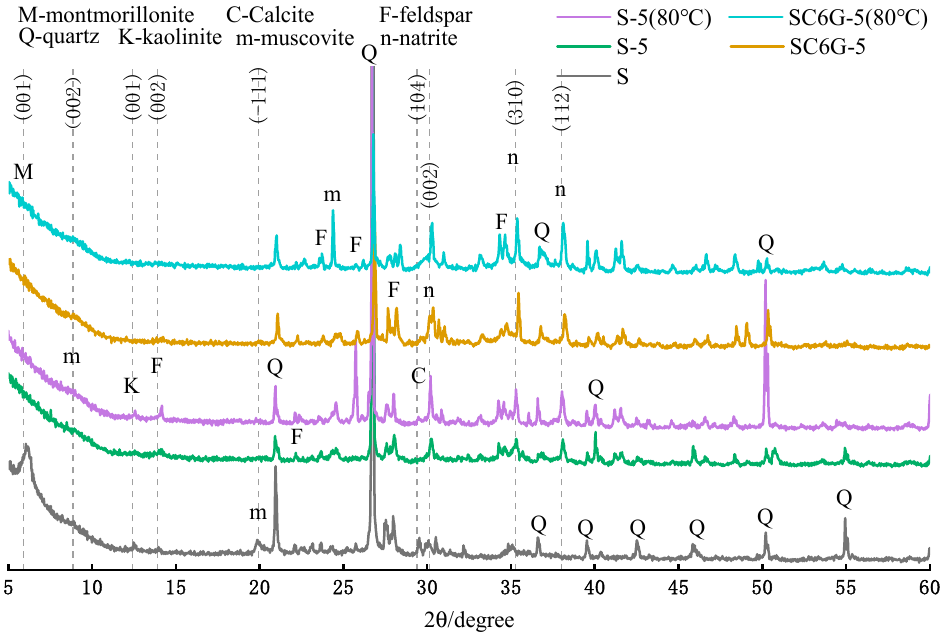
Figure 10. XRD of the residues after leaching. (S: WPS sample immersed in distilled water for 28 days curing at 20 °C; S-5: WPS was immersed in a solution of 5.0 M NaOH for 28 days curing at 20 °C; and S-5 (80 °C): WPS was immersed in a solution of 5.0 M NaOH for 3 days curing at 80 °C). In addition, the presence of obvious diffraction natrite peaks is observed, which confirms the conclusion obtained in Figure 6. The calcite peaks disappeared when the concentration of the leaching agent was 5.0 M, which is also consistent with the conclusion obtained in Figure